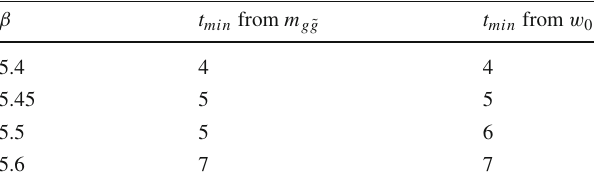
Table 2 The values of t min at fixed physical temporal distance from scaling with the gluino-glue mass m g ˜ g and with the Wilson flow param- eter w 0 β t min from m g ˜ g t min from